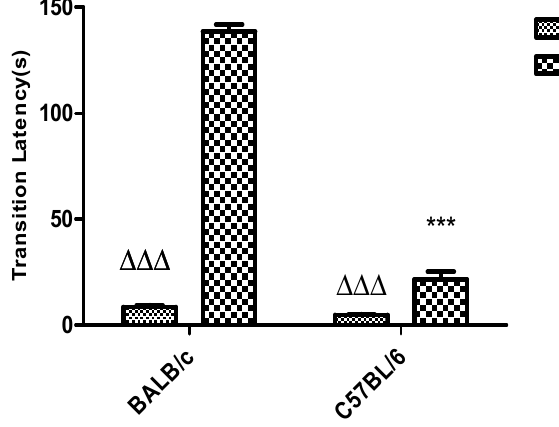
Figure 8. Response to the passive avoidance task in strains BALB/c and C57BL/6J. Data shows mean ± standard deviations for groups. * Differences between both strains for experimental groups. ∆ Differences between experimental and control groups (not electric shock) for each strain. A two-way ANOVA was used and p < 0.05.